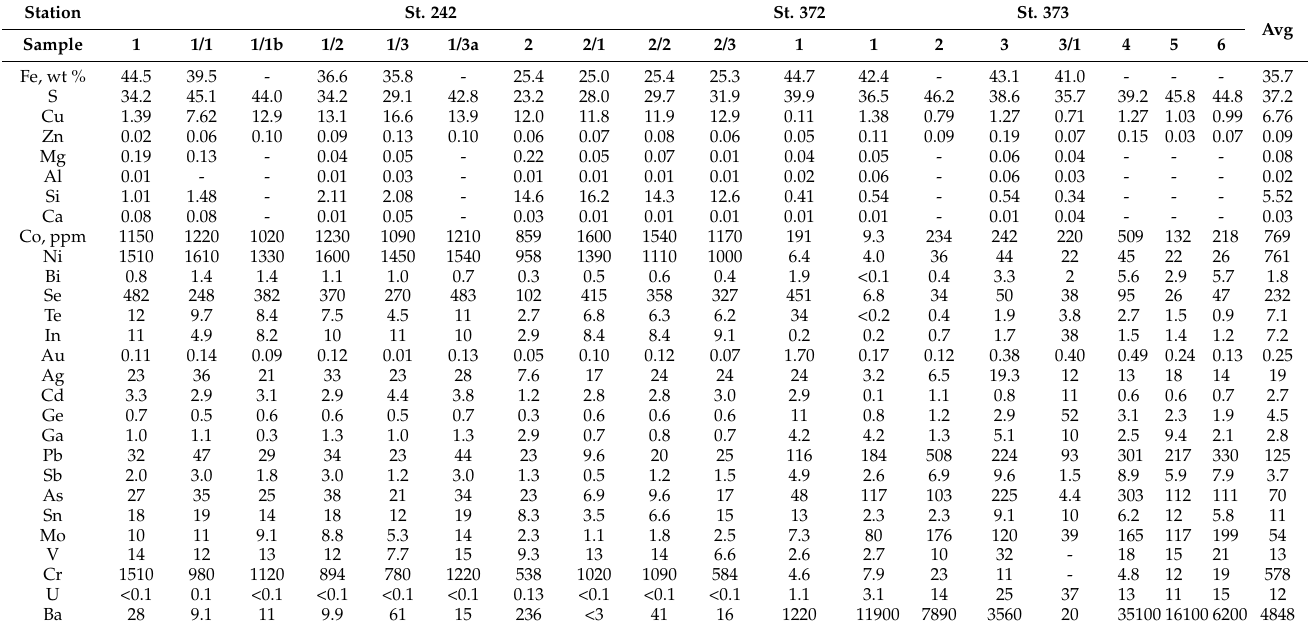
Table 7. The chemical composition of sulfide samples from Semenov-5 hydrothermal field.